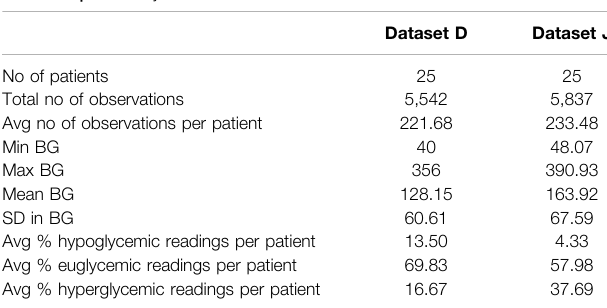
TABLE 2 | Summary statistics for datasets D and